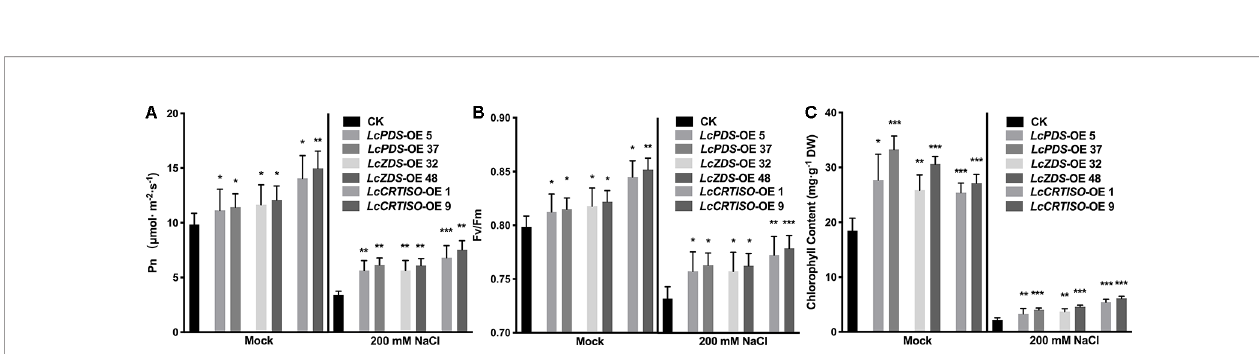
FIGURE 4 | Photosynthetic analysis in LcPDS , LcZDS , and LcCRTISO over-expressing tobacco lines under salt stress were assayed. (A) Net photosynthesis rates, (B) maximum quantum ef fi ciency of PSII, and (C) chlorophyll content in the leaves were measured. Data were obtained from three independent experiments and ANOVAs was performed. The results were presented as means ± SD. P values of < 0.05 (*), < 0.01 (**), and < 0.001 (***) were considered to be signi fi cant